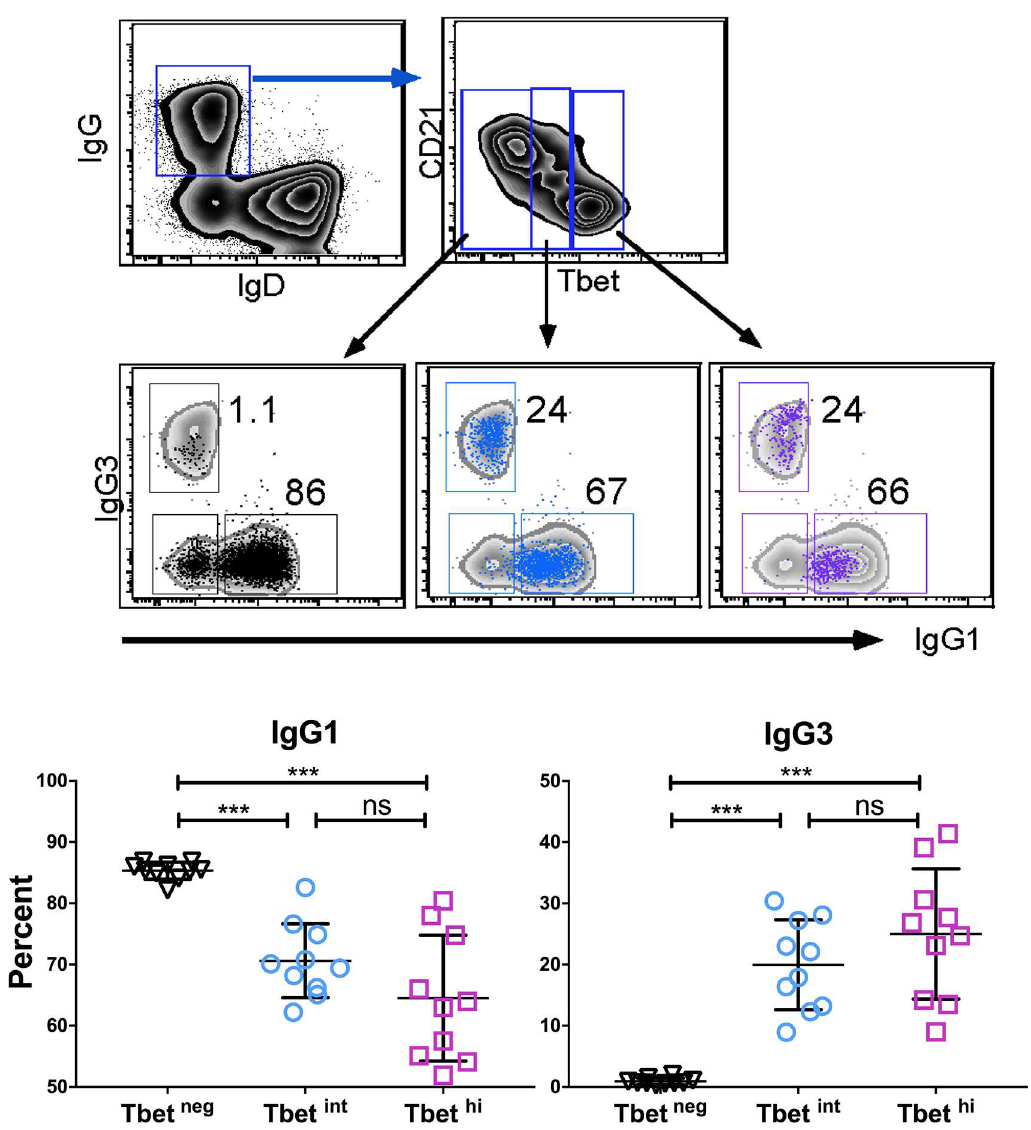
Fig 6. T-bet expression in B cells of malaria-exposed children associateswith IgG3 class switching. Percentage of CD19+ B cells that express surface IgG1 or IgG3 stratified by level of T-bet expression(n = 9 Malian children; representative subject, top). p values determinedby pairedStudent’s t test with Bonferroni corrections for multiplecomparisons where appropriate. **** P < 0.0001, *** P < 0.001, ** P < 0.01, * P < 0.05,ns = not significant.